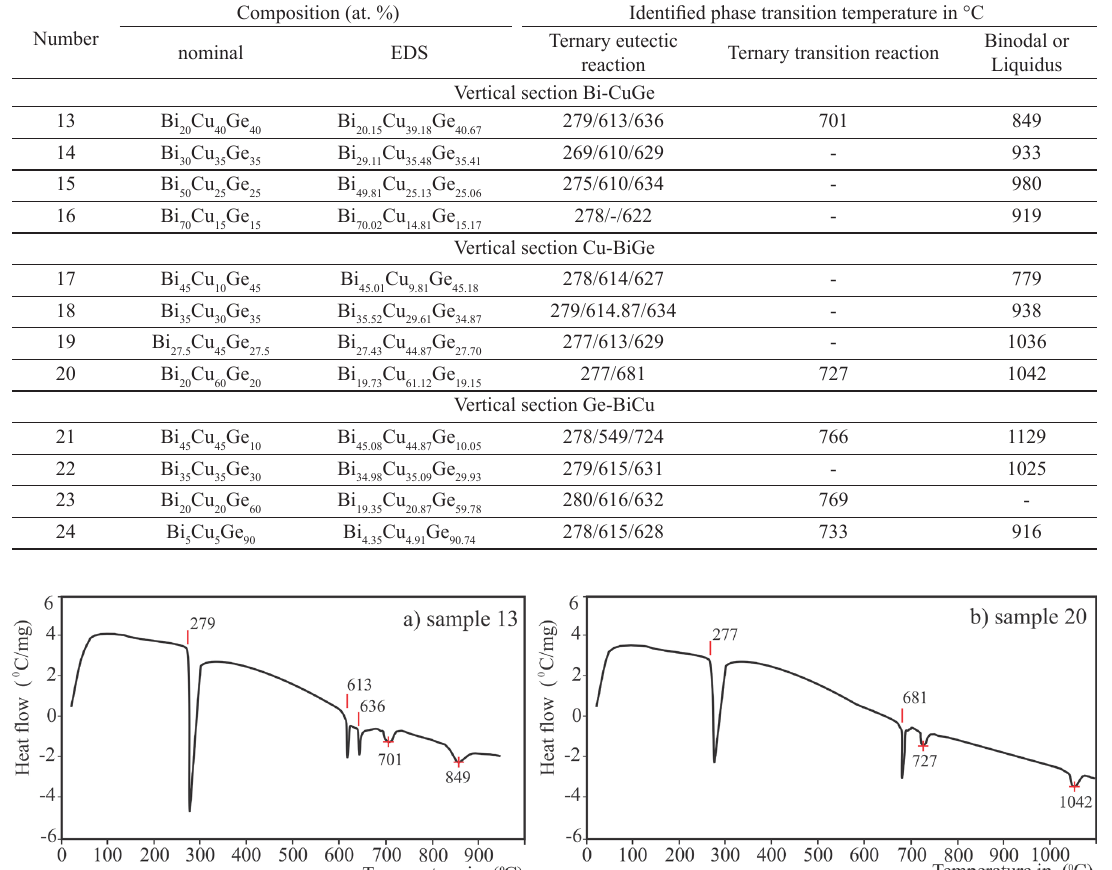
Table 4. Phase transition temperatures of the studied alloys from the ternary Bi-Cu-Ge system determined by DTA at pressure p = 0.1 MPa. Composition (at. Number